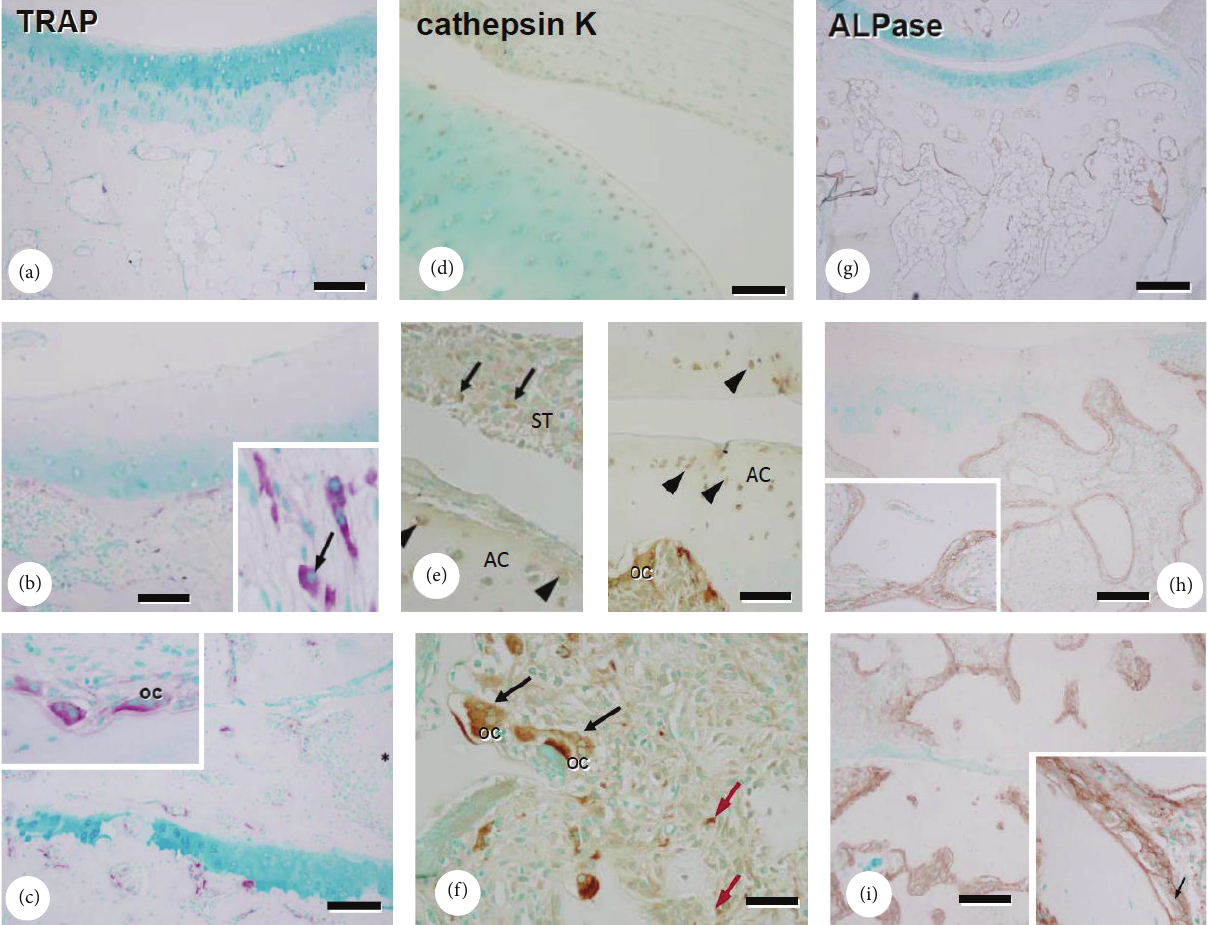
Figure 4: TRAP and ALPase staining and immunolocalization of cathepsin K in sagittal sections of PIP joints. TRAP staining in controls (a) and in arthritis with moderate (b) and severe (c) joint destruction. Immunolocalization of cathepsin K in controls (d) and in arthritis with moderate (e) and severe (f) joint destruction. In moderate joint destruction, the immunolocalization of cathepsin K was observed in osteoclast, cells in synovial tissue (arrows, e) and chondrocytes (arrowheads, e). In severe joint destruction, the immunolocalization of cathepsin K was observed in osteoclast (black arrows, f) and cells in connective tissue near articular joint (red arrows, f). ALPase staining in controls (g) and in arthritis with moderate (h) and severe (i) joint destruction. Black arrows, strongly cathepsin K-positive osteoclast; AC, articular cartilage; ST, synovial tissue; OC, osteoclasts. Bars: (a)–(c): 120 𝜇 m, (d)–(f): 100 𝜇 m, and (g)–(i): 300 𝜇